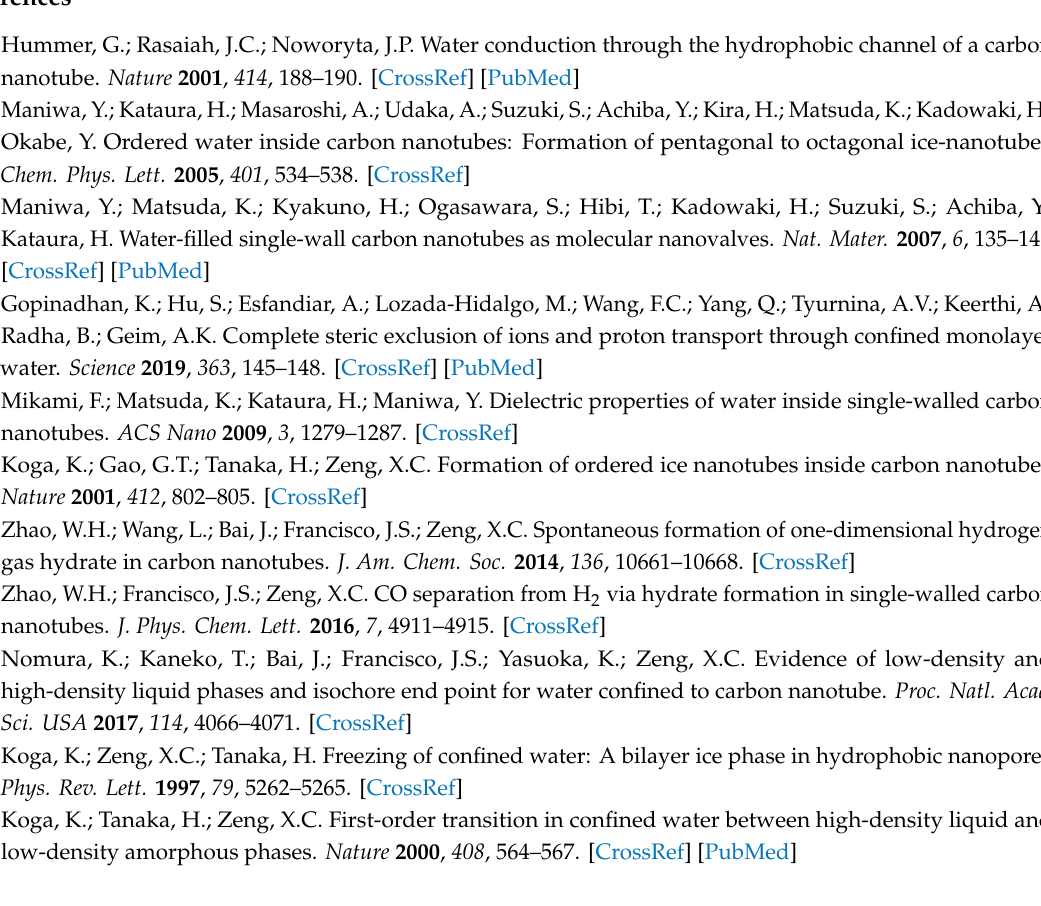
Figure S1: The side view of the snapshot for a water molecule positioned at the nanopore. Figure S2: The side views of the snapshot for Pore-IV under E = 3V / nm at t = 0 ns (A) and t = 100 ns (B). The numbers of water molecules between the graphene walls during the simulation (C). Time dependence of orientational order (S) of water molecules in nanocavity and in vacuum chamber (D), Figure S3: The snapshots for the cases of Pore-I (A), Pore-II (B), and Pore-III (C) under electric field. Figure S4: The hydrogen bonding networks of the system evolution for Pore-I during the simulation under E = 3 V / nm. Figure S5: The density profiles of water molecules along the z